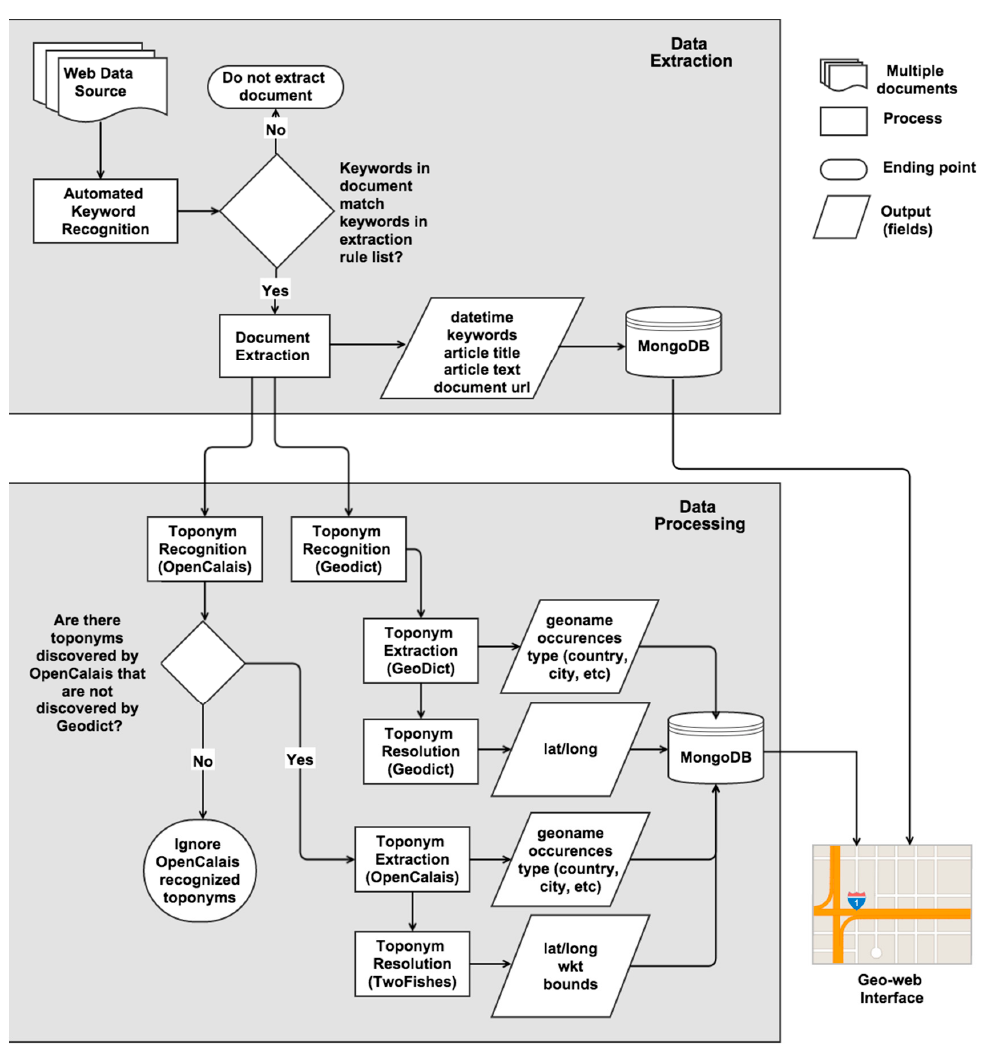
Figure 2. Process diagram outlining flow of data through the automated data extraction and processing stages.